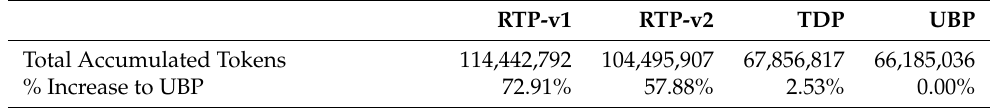
Table 5. Total accumulated tokens from our experiment in Figure 3.